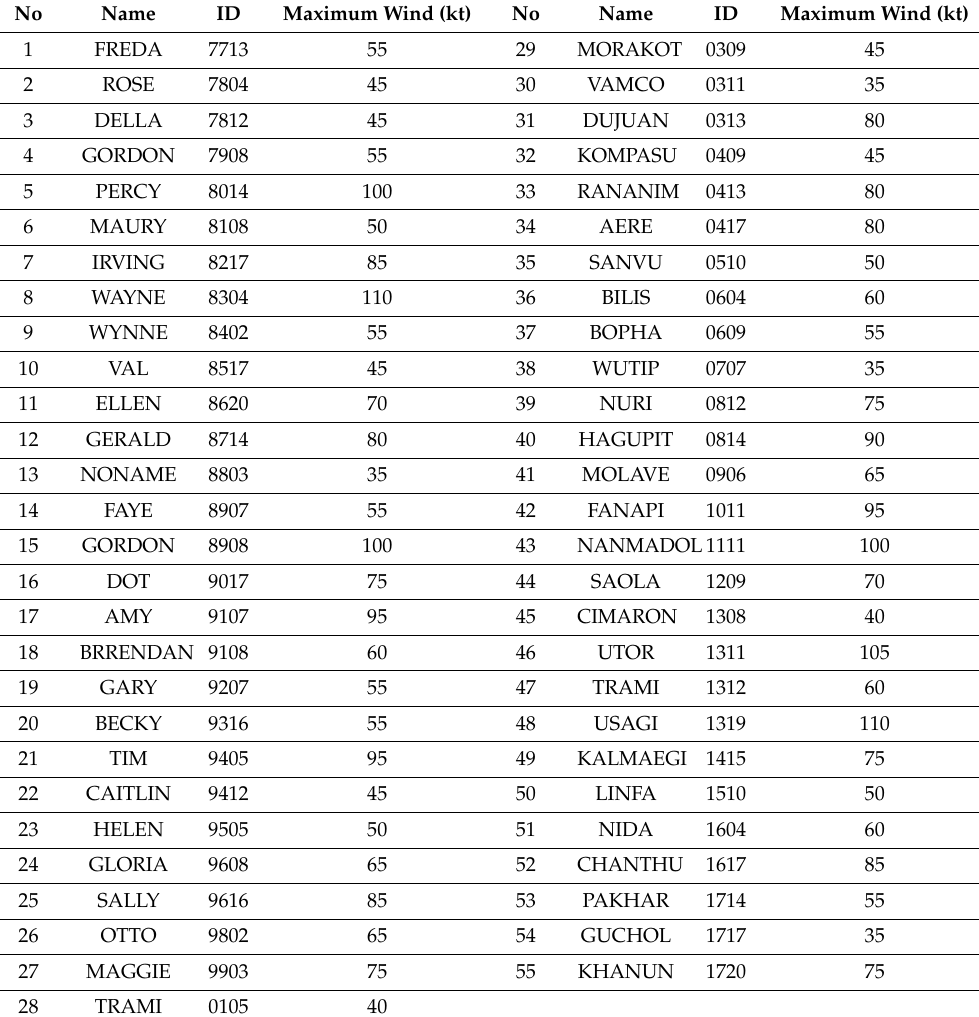
Figure 1. Weather stations and typhoon track data used in the present study: ( a ) the locations of the meteorological stations ( n = 537); and ( b ) the long-term average of the tropical cyclone (TC) track density in the western North Pacific (WNP) region during the period 1961–2017. The solid line in ( b ) indicates the location of the WNP subtropical high represented by 5880 gpm during the study period. Table 1. The 55 typhoons used in the present